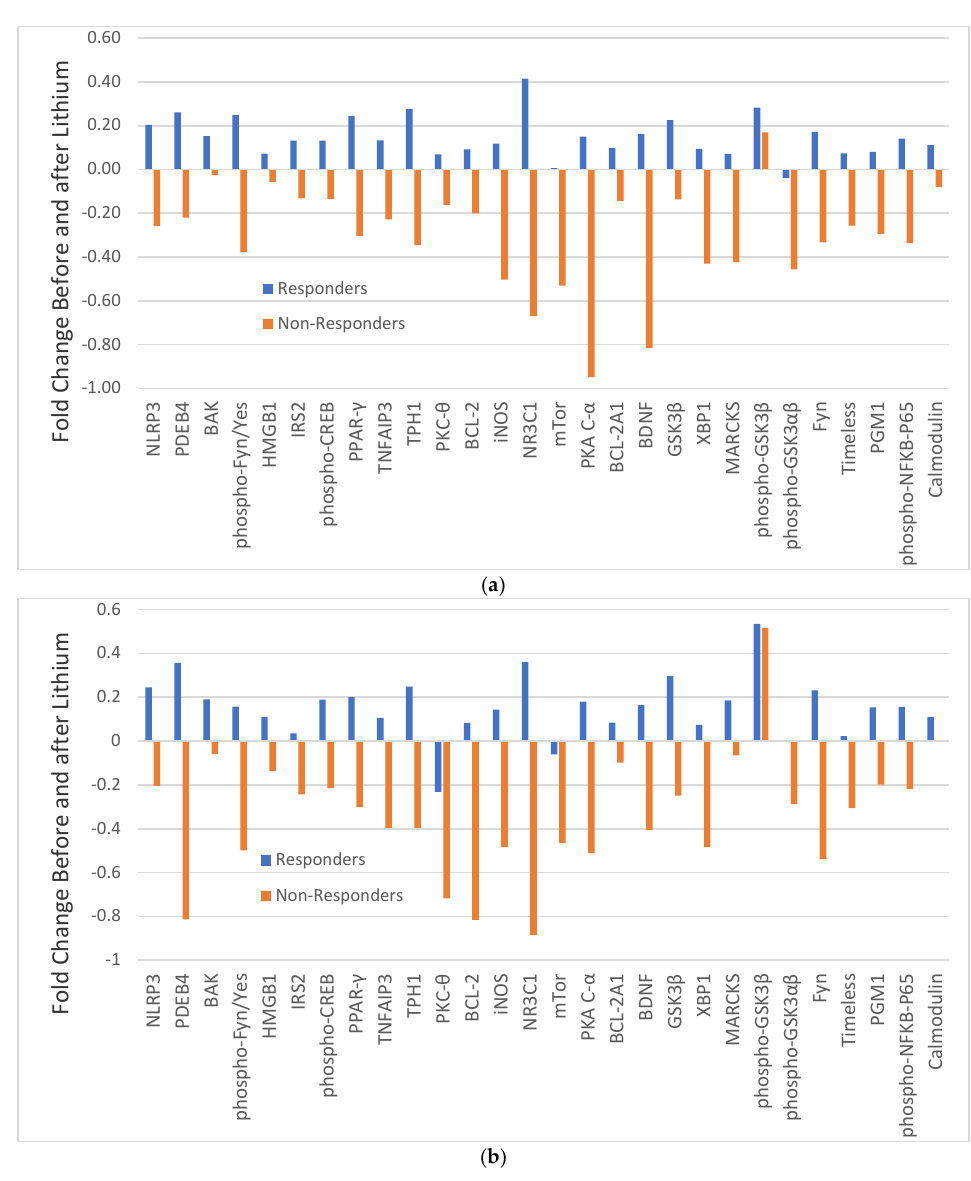
Figure 2. Fold change (FC) of 28 analytes in monocytes (a) and CD4 + lymphocytes (b) in responders (blue bars) and non-responders (brown bars) before and after lithium. Note: FC = log2 (median flu- orescent ratio of after lithium/median fluorescent ratio of before lithium Positive value is indicative of a higher level of protein expression after lithium than before lithium. Negative value is indicative of a lower level of protein expression after lithium than before lithium. Abbreviations: BAK: BAX, BCL2-Associated X Protein; BCL-2: B-cell lymphoma 2; BCL-2 A1: Bcl-2-related protein A1; BDNF: brain-derived neurotrophic factor; Calmodulin: calcium-modulated protein; ; Fyn: a tyrosine kinase belongs to the Src family of tyrosine kinases including src, fyn, and yes; GSK3 𝛽 : glycogen synthase kinase 3 beta; HMGB1: High mobility group box 1 protein; iNOS: inducible isoform nitric oxide synthases; IRS2: Insulin receptor substrate 2; MARCKS: myristoylated alanine-rich C-kinase sub- strate; mTor: mammalian target of rapamycin; NLRP3: NACHT, LRR and PYD domains-containing